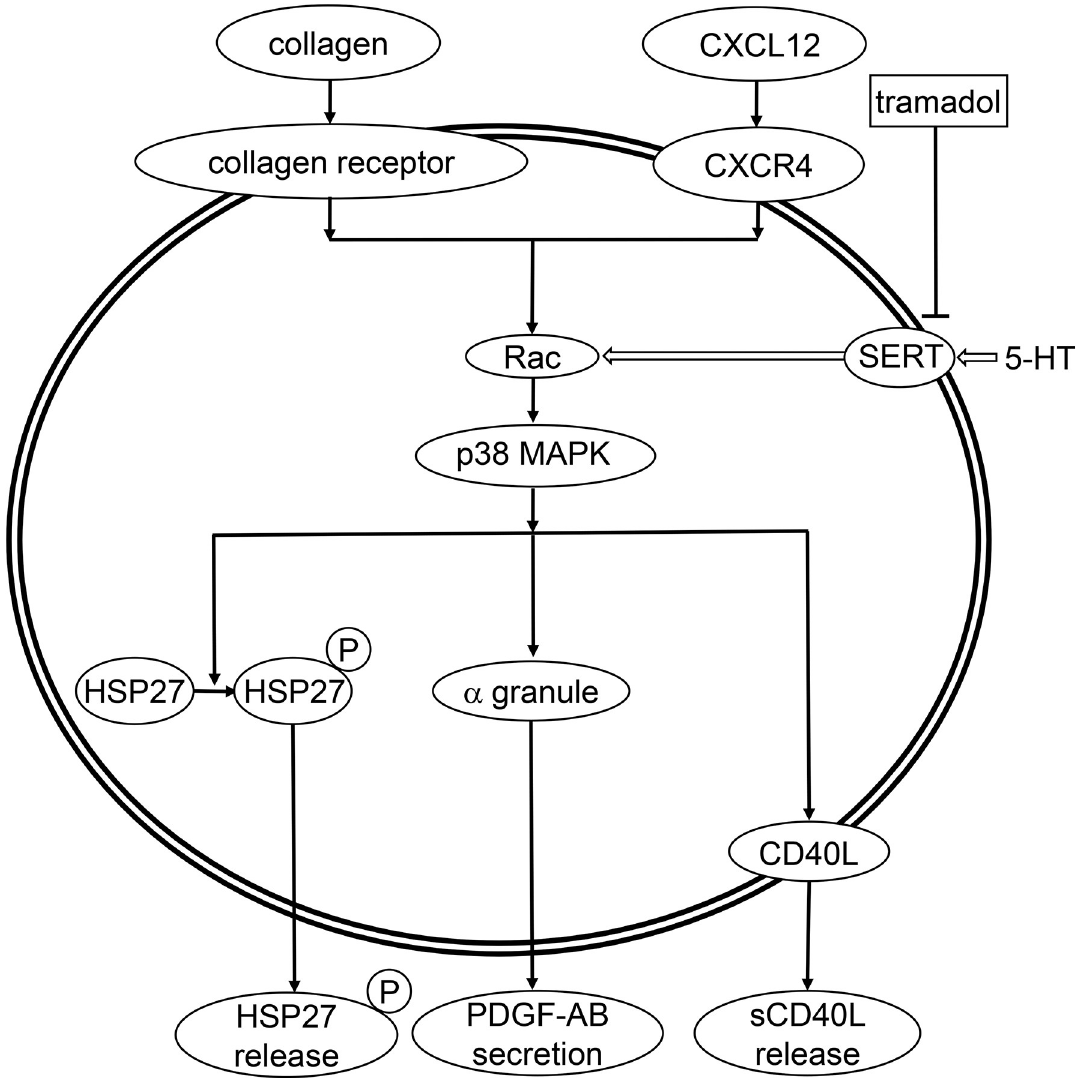
Fig 7. Diagram of the potential mechanism underlying the role of SERT in the platelet activation by simultaneous stimulation with subthreshold collagen and CXCL12. 5-HT, 5-hydroxy-tryptamine; SERT, serotonin transporter; MAPK, mitogen-activated protein kinase; HSP, heat shock protein; P, phosphorylation; PDGF-AB, platelet-derived growth factor-AB; CD40L, CD40 ligand; sCD40L, soluble CD40 ligand.